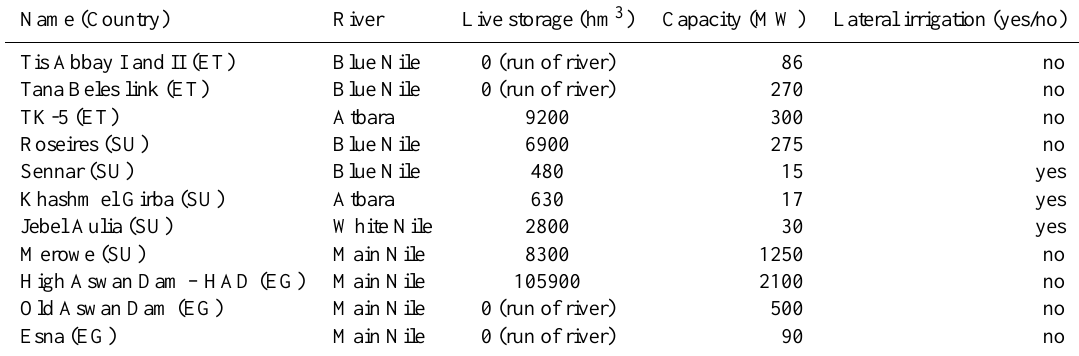
Table 1. Main completed dams and hydropower plants in the Eastern Nile River